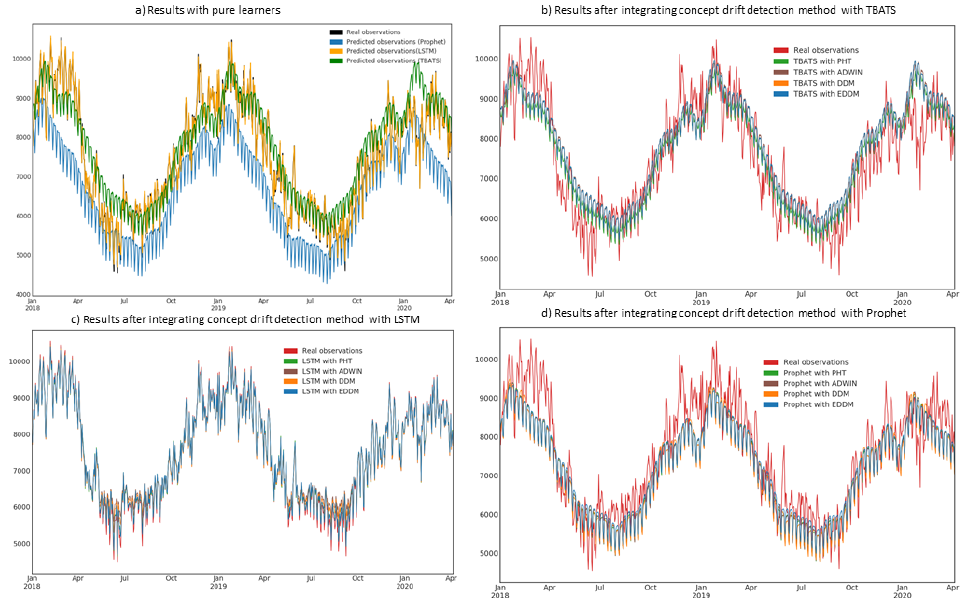
Figure 6. Prediction results from time series learners (see Section 3) for Fingrid [74], where X axis shows DateTime and Y axis the value in megawatt hour (MWh). Figure ( a ) shows results from pure learners, where figures ( b – d ) show results after integrating concept drift